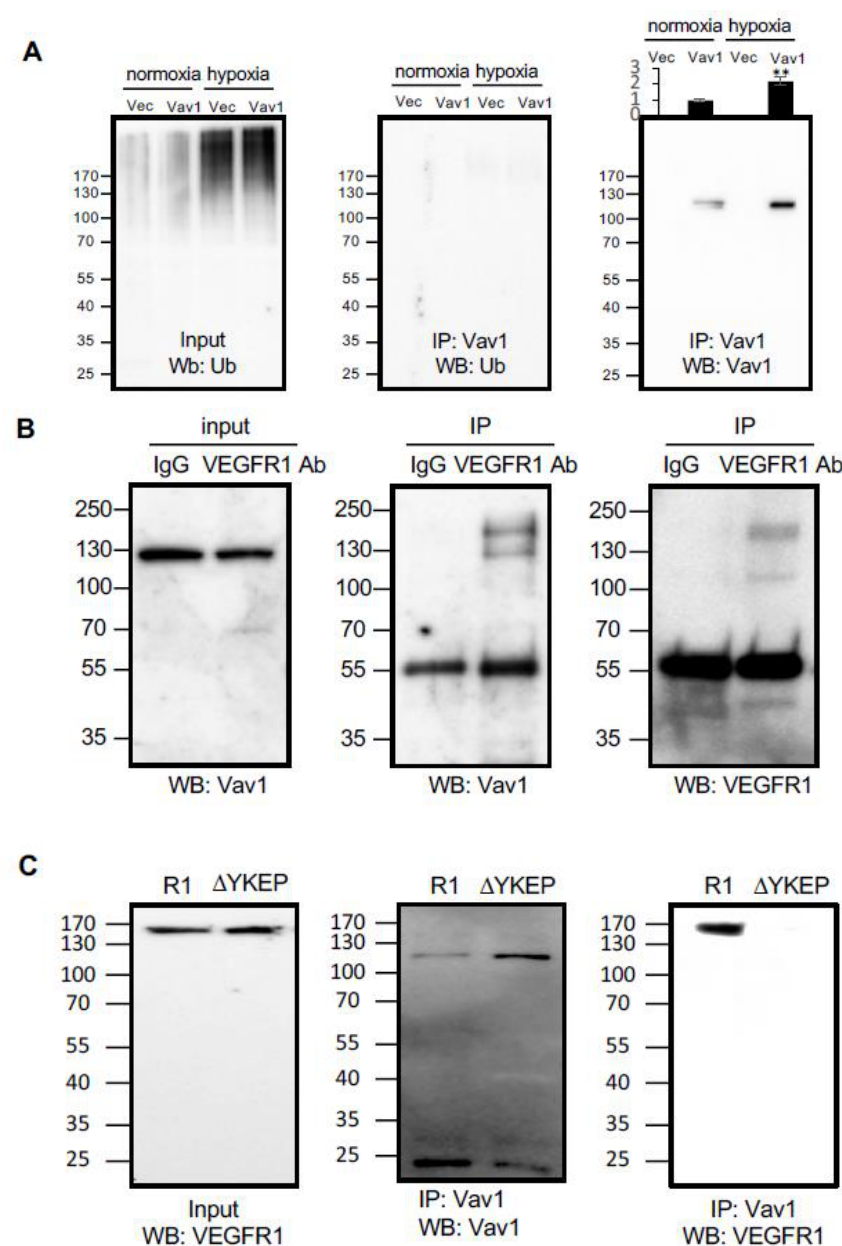
Figure 2. Vav1 binds to vascular endothelial growth factor receptor 1 (VEGFR1). ( A ) Either Flag-tagged Vav1 or empty vector control were transduced into HUVEC cells and incubated under normoxic or hypoxic conditions. Cell lysates were subjected to Vav1 immunoprecipitation and subsequent Western blot analysis for ubiquitin (middle panel) or Vav1 as a control (right panel). Ubiquitin levels were also detected in both control and Vav1 cells exposed to hypoxia from the input of the immunoprecipitation (left panel). ( B ) VEGFR1 and Vav1 were immunoprecipitated by anti-VEGFR1 antibody or control IgG from the cell lysate of HUVEC cells. Vav1 was probed from the input lysate (left) and pulldown product (center). VEGFR1 was detected from the pulldown product (right). ( C ) Overexpressed wild type (R1) or YKEP motif deleted ( ∆ YKEP) VEGFR1 were co-IPed with Vav1 antibody. The input was probed with VEGFR1 antibody (left). The pulldown product was probed against Vav1 (center) or VEGFR1 antibody (right). Mean ± SD, * p < 0.05, ** p <